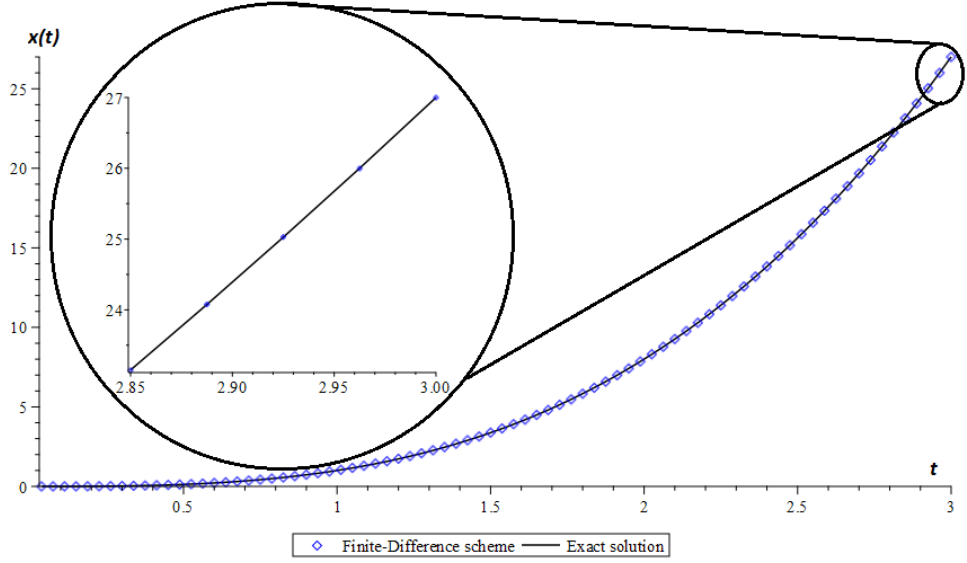
Figure 1. Test example. Numerical and exact solutions of problem (23) in case of fulfillment of the condition of Theorems 2 and 3.